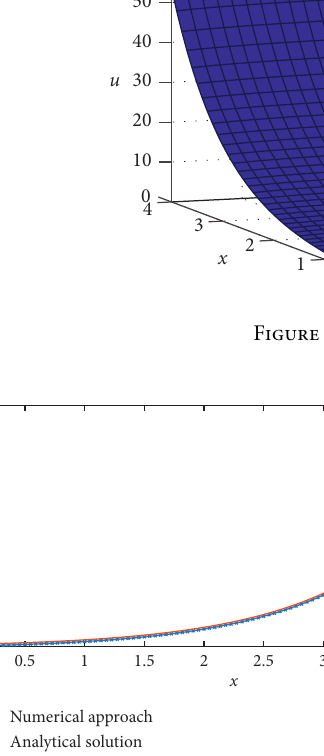
Figure 5: Analytical solution vs numerical approximation with α � 0 . 5. Table 2: Option values when E < S .